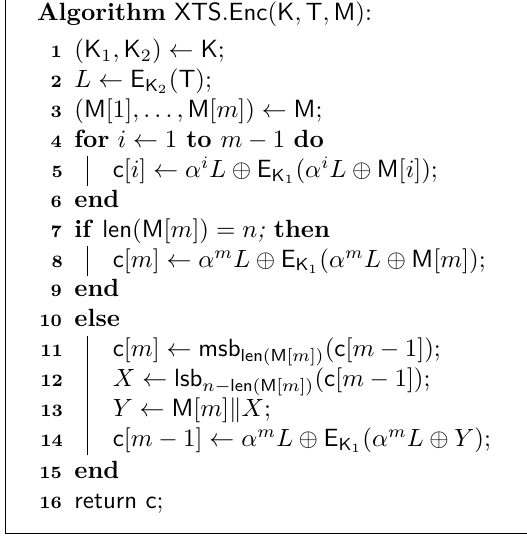
Figure 5: XTS block-cipher mode. Here T is the index of sector on which the encryption of data M is to be stored. In the context of OCB2, T can be seen as a “nonce”. Also, α is a generator of the field F n 2